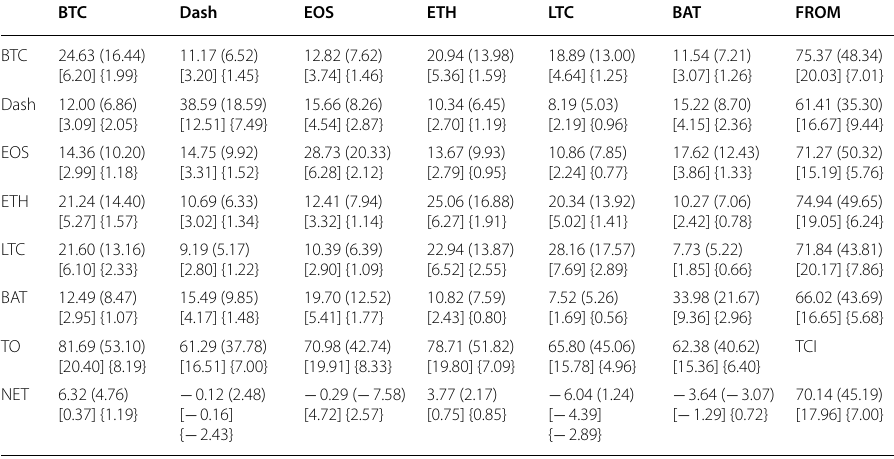
Table 8 Averaged connectedness table-RSV-N